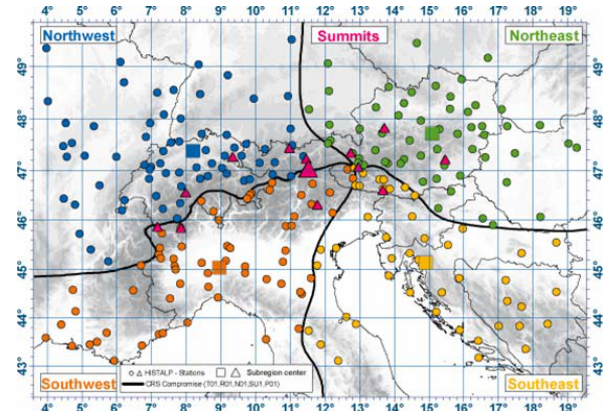
Fig. 6. HISTALP temperature anomalies from 1901–2000 averages; (Auer et al., 2007) blue dots (northwest stations); green dots (northeast stations); orange dots (southeast stations); red dots (southwest stations).